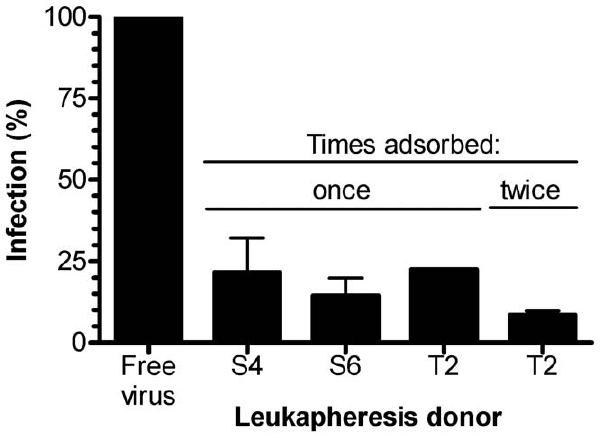
Figure 5. Erythrocyte preparations selectively adsorb most of the infectious HIV-1 virions. HIV-1 isolate 89BZ_167 (105,900 pg) was adsorbed with erythrocytes the indicated numbers of times by adding 3.5 6 10 9 erythrocytes from the indicated donors. After removing the erythrocytes by centrifugation, non-adsorbed virus in the superna- tant was assayed for the ability to infect CD4( + ) TZM-bl cells in trans . The relative degree of infection, determined by the mean p24 ( 6 SD of triplicate measurements), was compared with infection by the original free virus (shown as 100%).